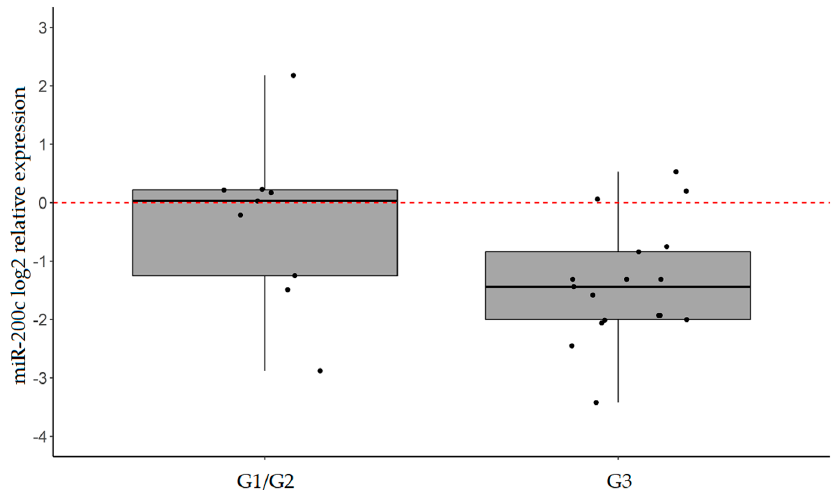
Figure 3. miR-200c and tumor grade. Box plots of miR-200c expression (log2 FC) in tumors grouped according to grade. p- value = 0.049 (Mann − Whitney test).